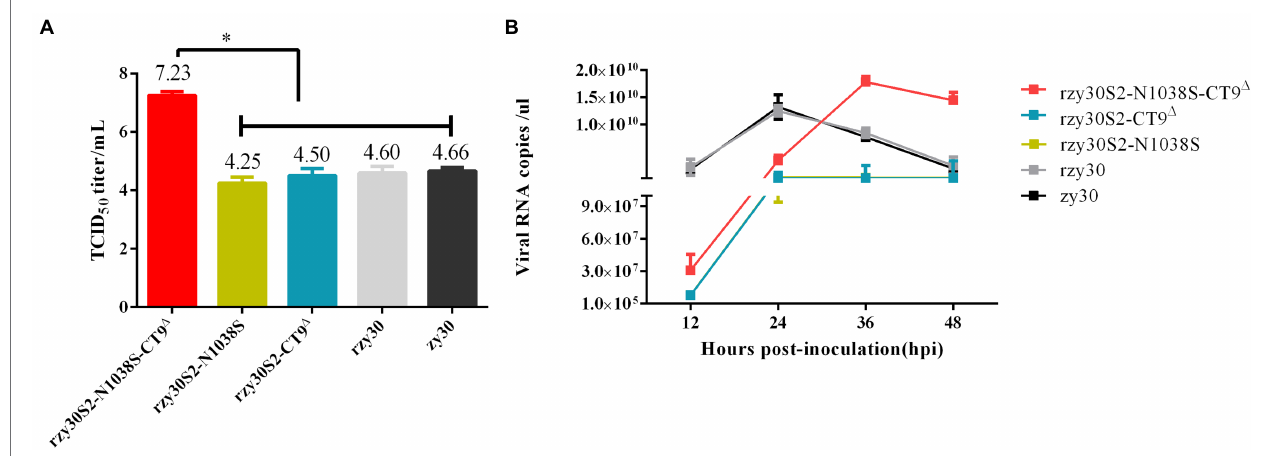
FIGURE 4 | The biological characteristics of rescued strains in vitro . The TCID50 titer (A) and viral RNA copies/ μ l (B) in CEK cells after infection with rzy30S2- N1038S-CT9 △ , rzy30S2-N1038S, rzy30S2-CT9 △ , rzy30, and zy30 strains. The Bonferroni test of ANOVA method was used to analyze the statistical difference of TCID50 titer (A) between different groups. *Significant difference between the analyzed group with other groups ( p <